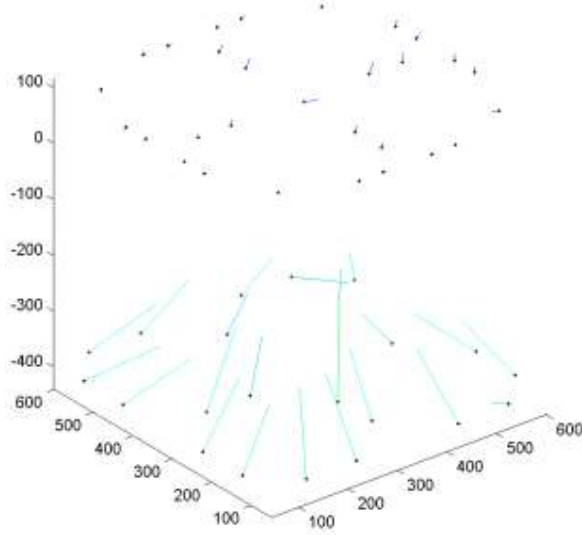
Figure 3: Representative 3D residual plot (here: 12MB dunk GT, test 5). Units are in mm with an enhancement factor for the residuals of 50.